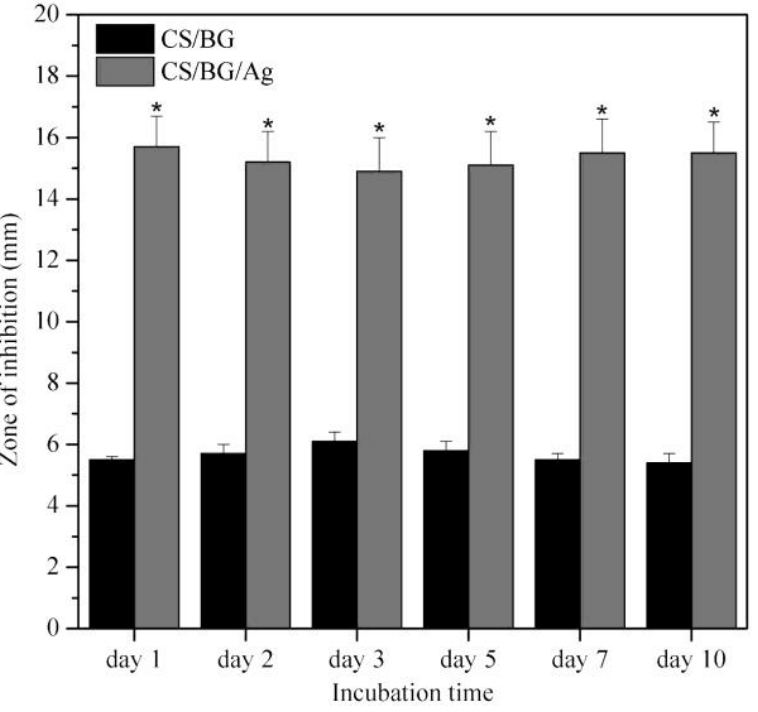
Figure 8. Evolution of the size of the inhibition zone after immersion in phosphate-buffered saline (PBS) of CS/BG (Chitosan/Bioglass) and CS/BG/Ag (Chitosan/Bioglass/silver nanoparticles): The data represent mean ± SD of three individual experiments (* p < 0.05 CS/BG/Ag vs. CS/BG. (adapted with permission from reference